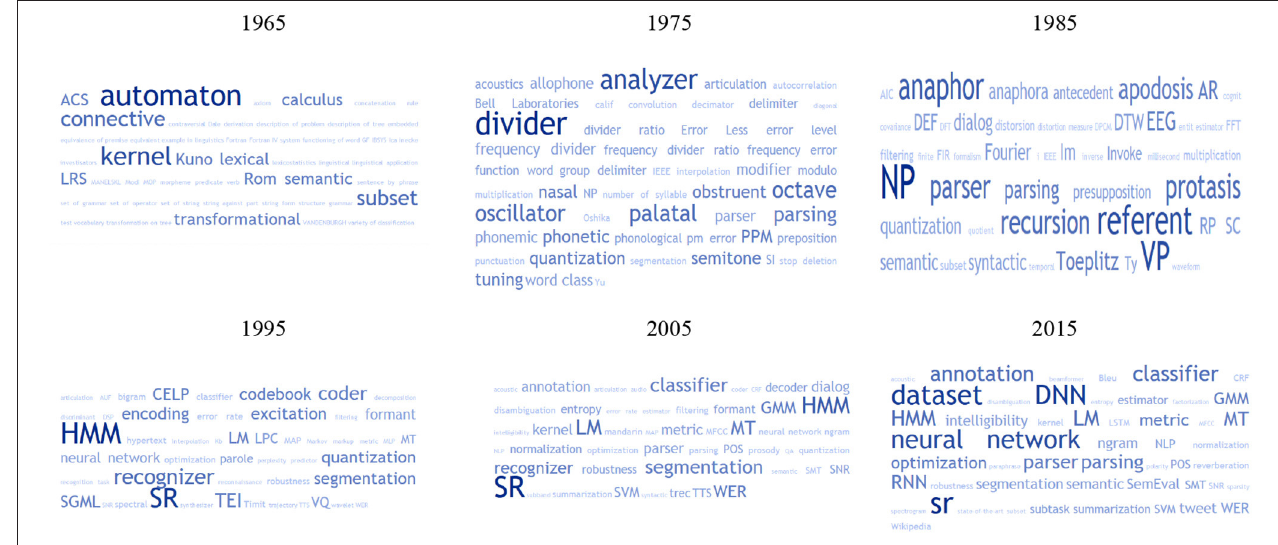
FIGURE 7 | Tag cloud based on the abstracts from 1965 to 2015.